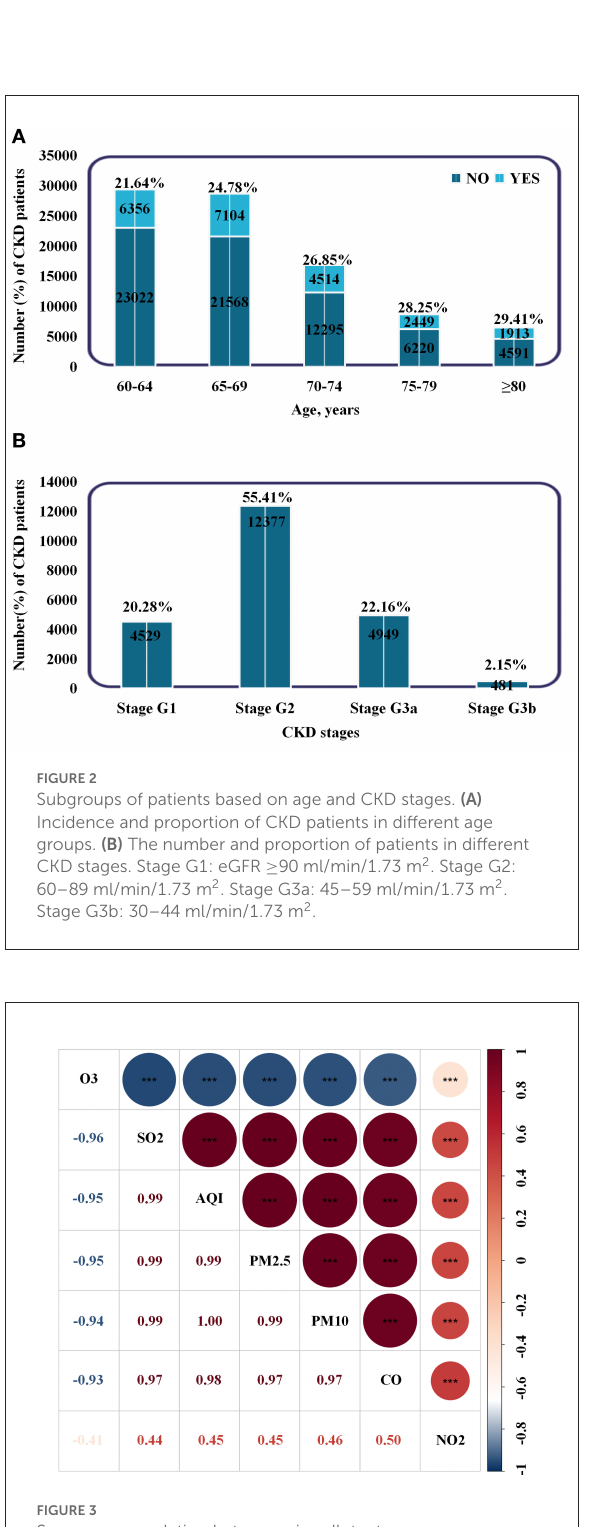
FIGURE3 Spearman correlation between air pollutants.